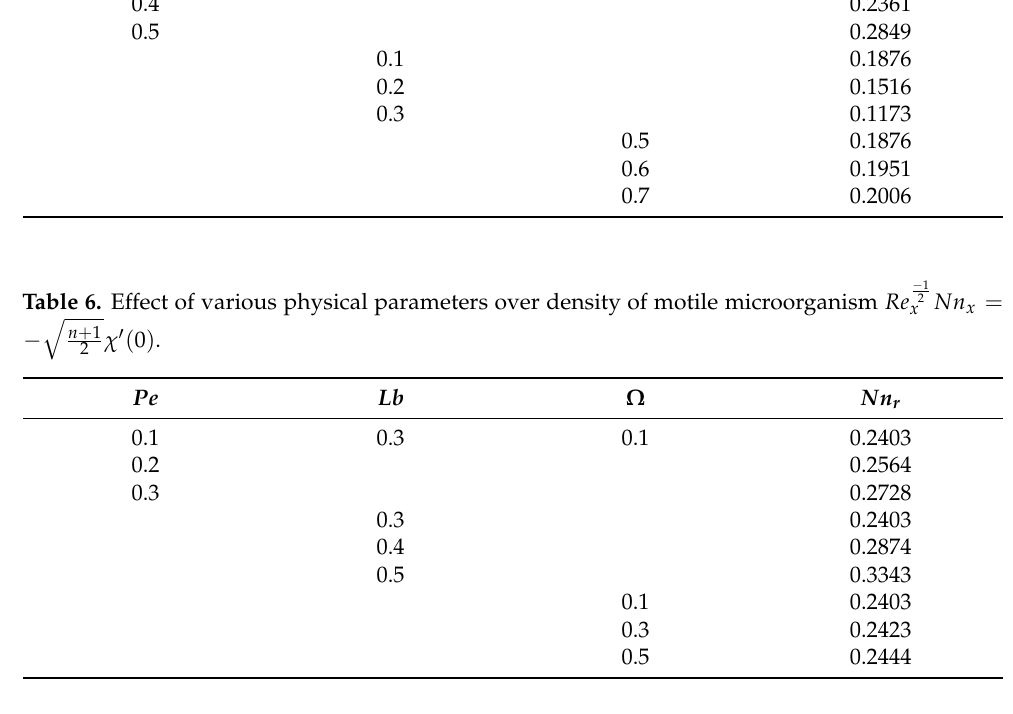
Table 5. Effect of various physical parameters over Sherwood number Re